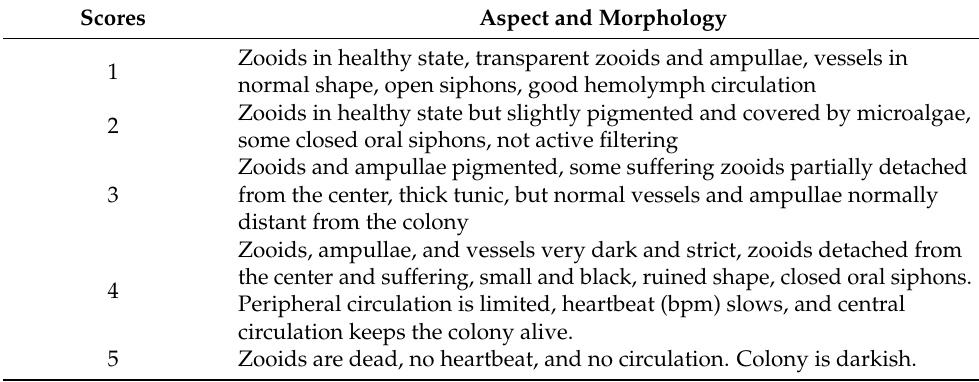
Table 2. Scores from 1 to 5 indicate the health state of colonies. The aspect and morphology of zooids and ampullae, pigmentation degree, appearance of circulatory systems, and transparency of the tunic were classified to record the health conditions of colonies [14].